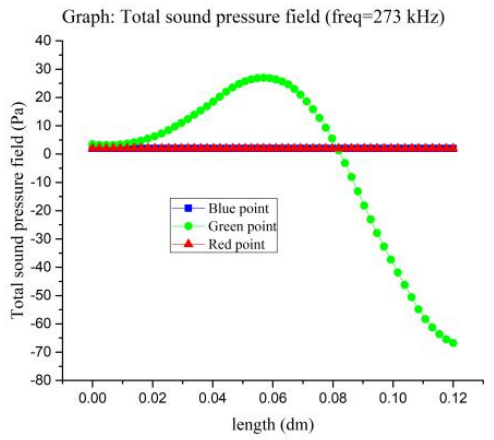
Figure 3. Sound pressure changes at di ff erent observation points.